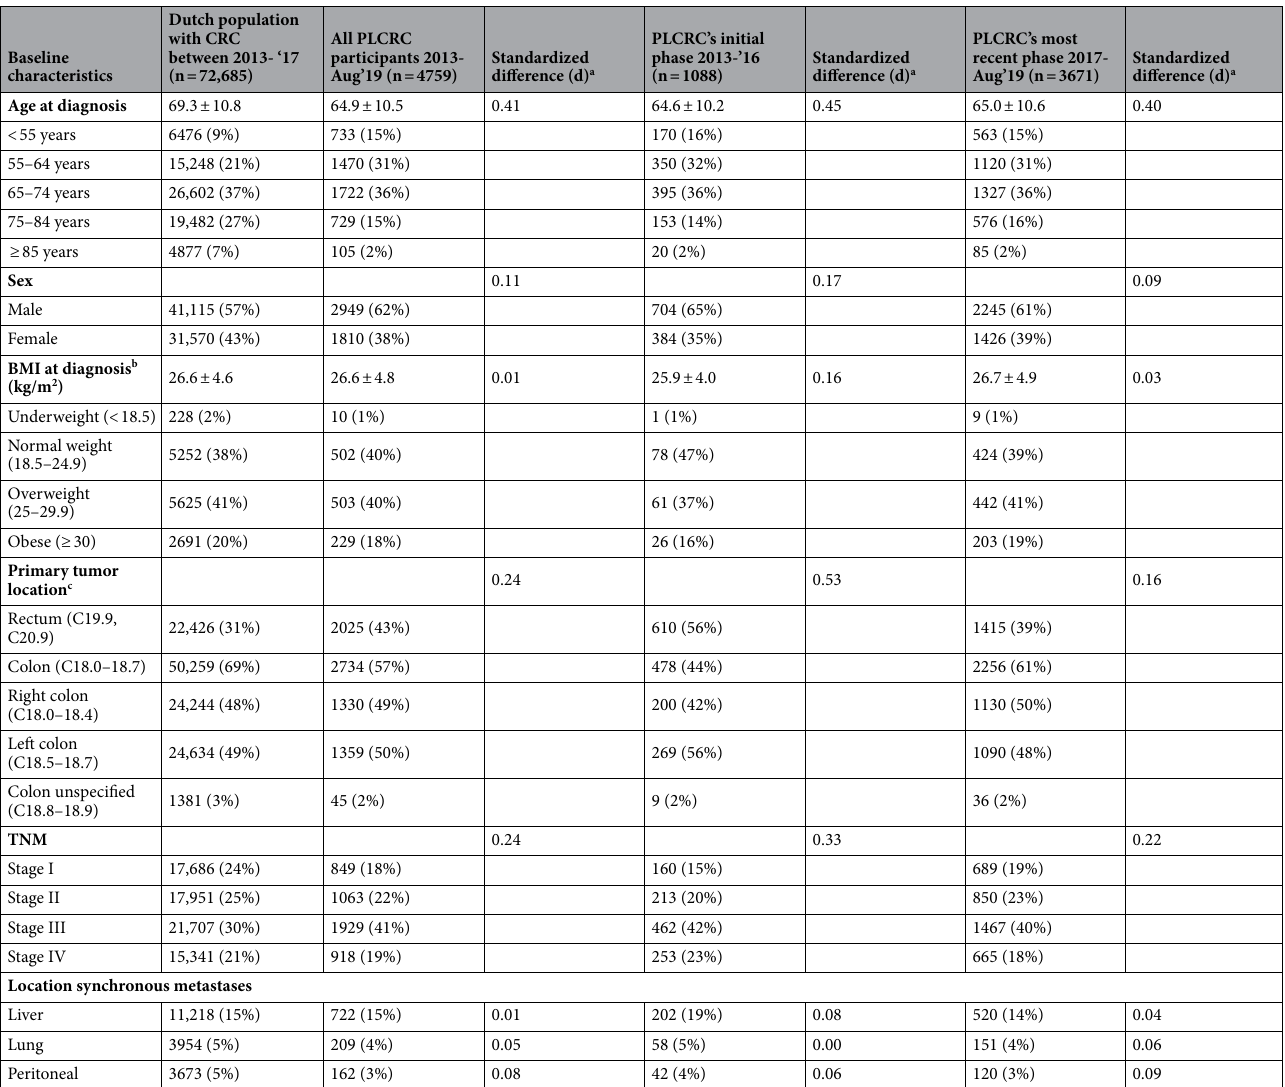
Table 2. Characteristics of PLCRC participants at diagnosis (2013-Aug’19), compared with the general Dutch CRC population (2013–’17), and stratified by time-period (2013–’16, and 2017–Aug’19). a Standardized differences (d) are differences in means or proportions divided by standard error; d > 0.20 indicate a large difference, d 0.10–0.20 indicate a small difference, and d < 0.10 indicate a negligible difference 17,18 . b BMI from patients diagnosed in 2015 (n = 13,796). c Standardized differences calculated over the proportion rectum versus colon